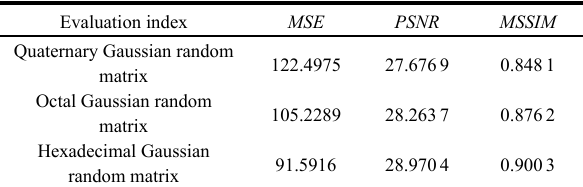
Table 1 Evaluation indices of reconstruction image under different measurement